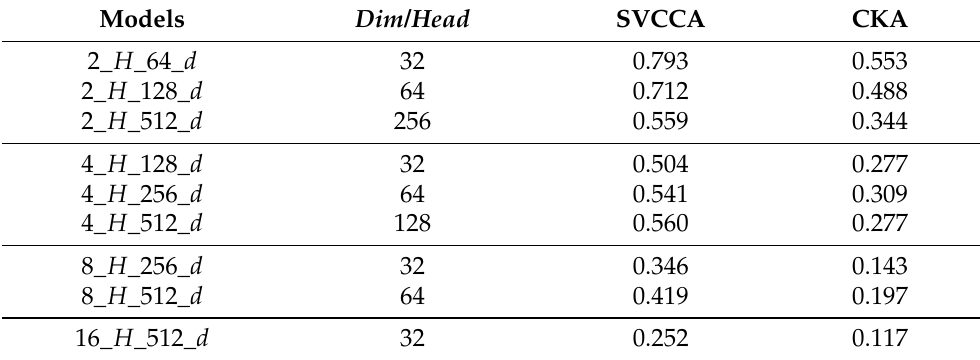
Table 3. Inter-head similarity with various numbers of heads and hidden